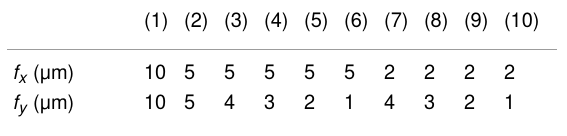
Table 1: Parameters of the feeds in the x - and y -direction for fabri- cating micro/nanostructures on the Cu(110) surface. (1) (2) (3) (4) (5) (6) (7) (8) (9)